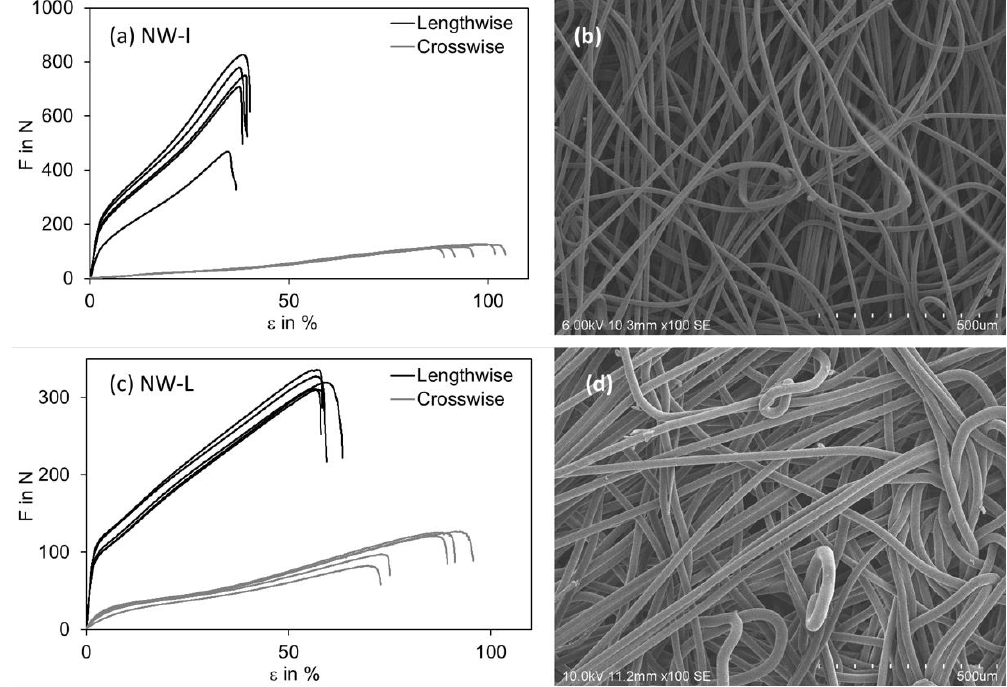
Figure 4. ( a , c ) Force–strain curves measured on NW-I and NW-L fabrics, respectively, along lengthwise and crosswise directions. SEM images of the nonwovens ( b ) NW-I and ( d ) NW-L.